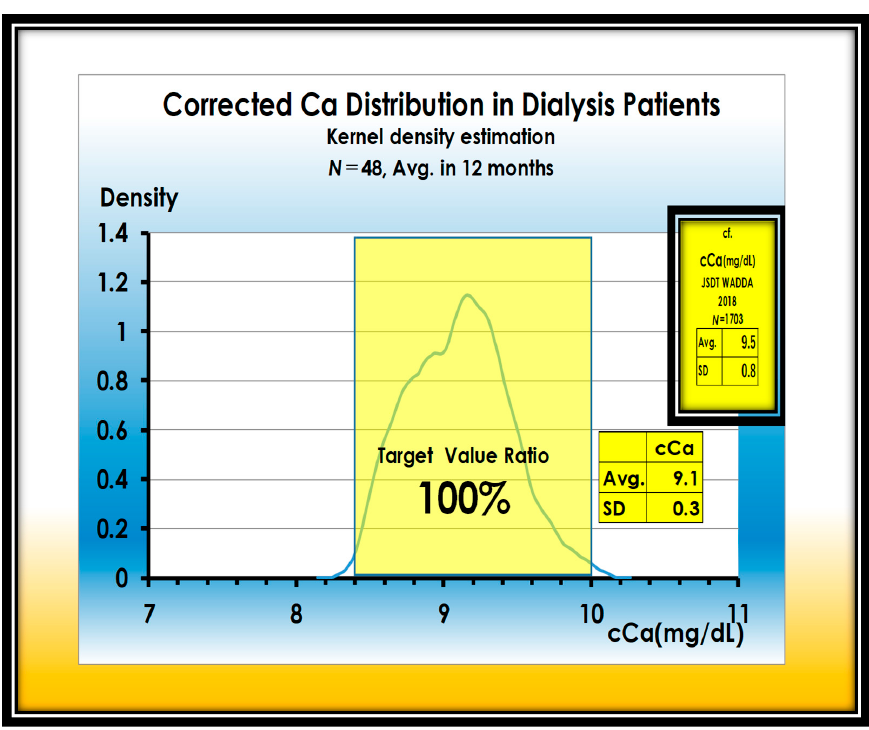
Figure 4. Adequate ratio of cCa in 48 dialysis patients is 100%.